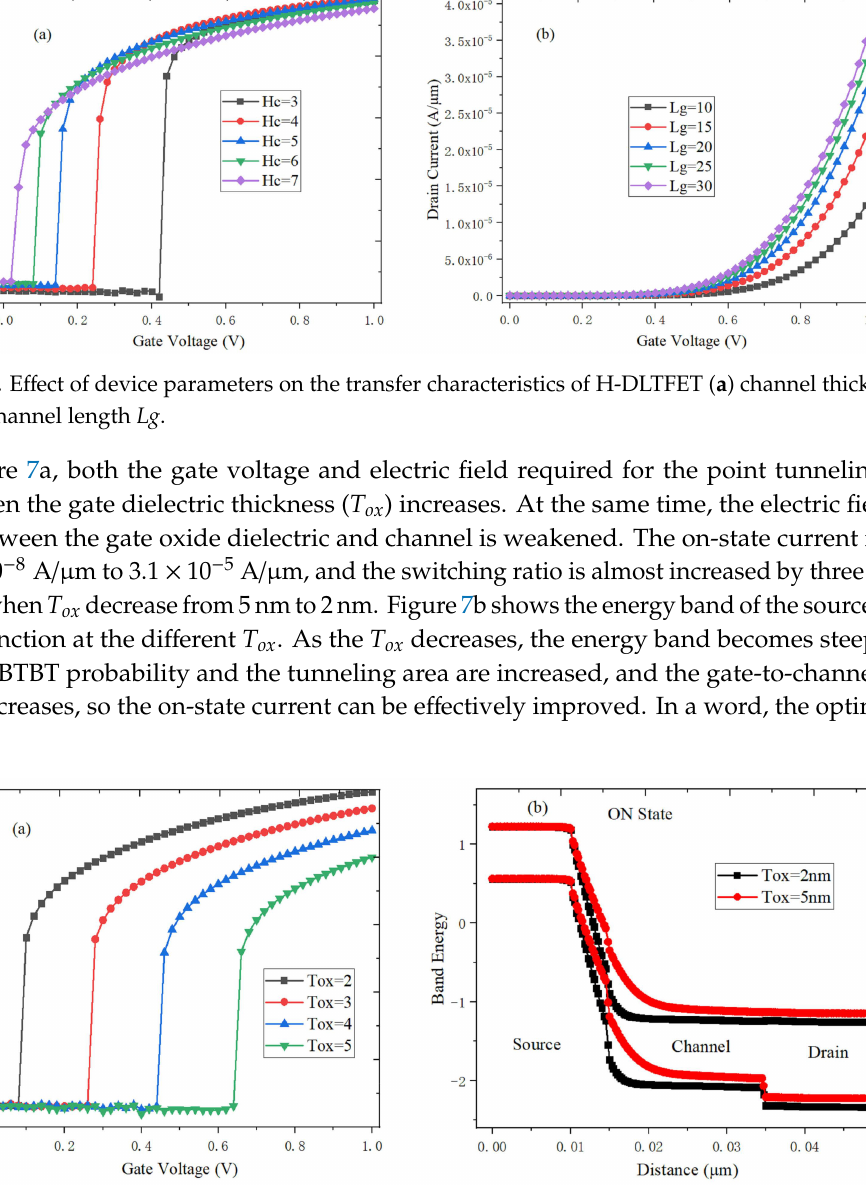
Figure 7. E ff ect of gate oxide thickness on ( a ) transfer characteristics, ( b ) on-state energy